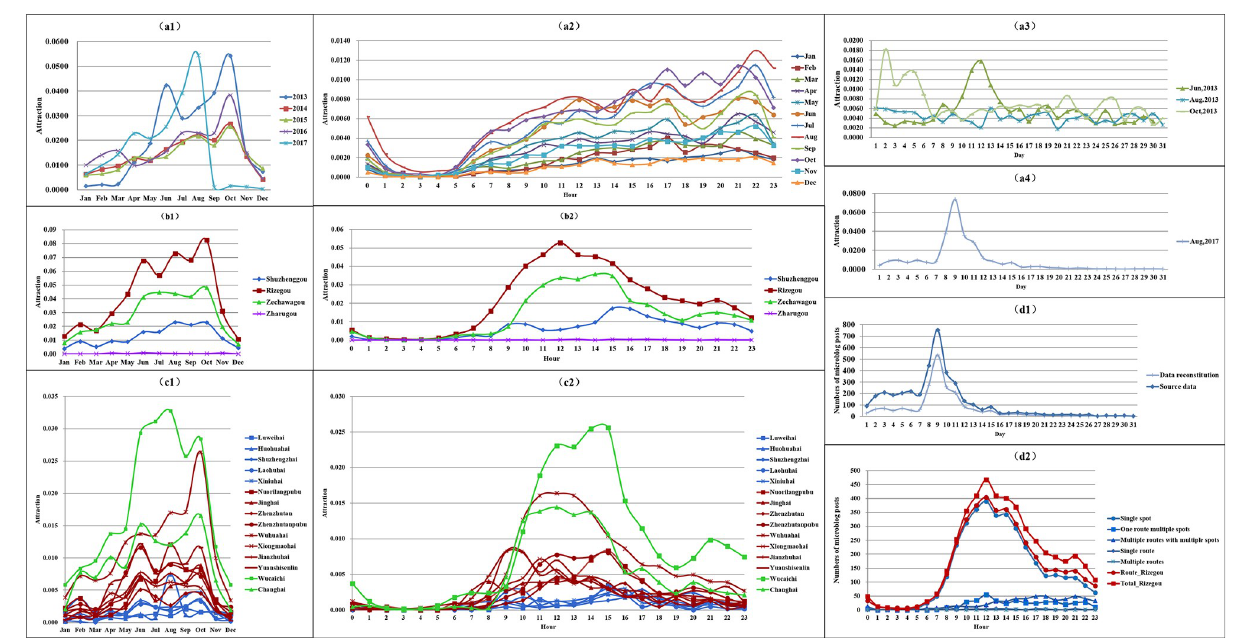
Fig 4. The variation tendencies of the popularity of Jiuzhaigou at various temporal scales. (a1) scenic areas at the monthly scale L 1&2 . (a2) scenic areas at the hourly scale L 1&4 . (a3) scenic areas for 2013 at the daily scale L 1&3_2013/b/c . (a4) scenic areas for 2017 at the daily scale L 1&3_2017/b/c . (b1) tourist routes at the monthly scale L 1&2 . (b2) tourist routes at the hourly scale L 1&4 . (c1) scenic spots at the monthly scale L 1&2 . (c2) scenic spots at the hourly scale L 1&4 . (d1) popularity based on the numbers of microblog posts in August 2017. (d2) popularity based on the numbers of microblog posts in Rizegou